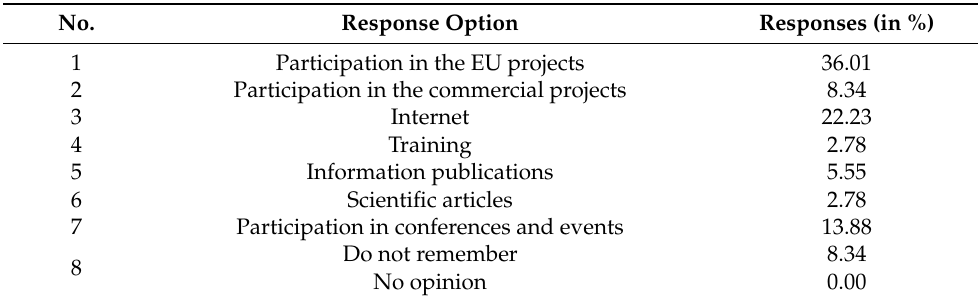
Table 3. Sources of knowledge about ESCO formula. Source: CAWI survey.